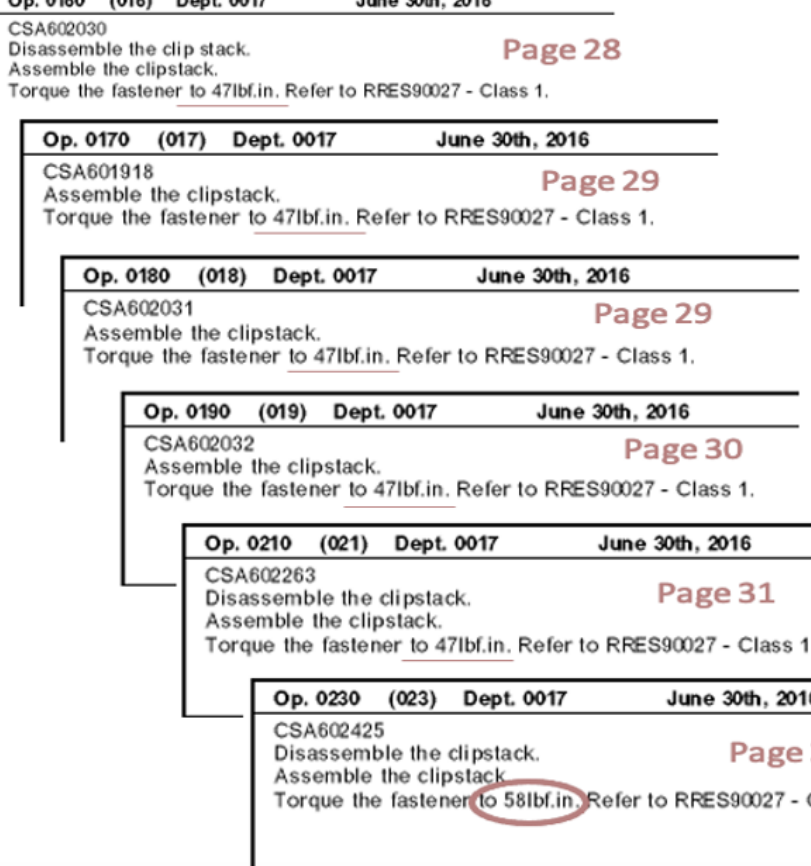
Figure 7. Successive SOPs overlap with similar action.